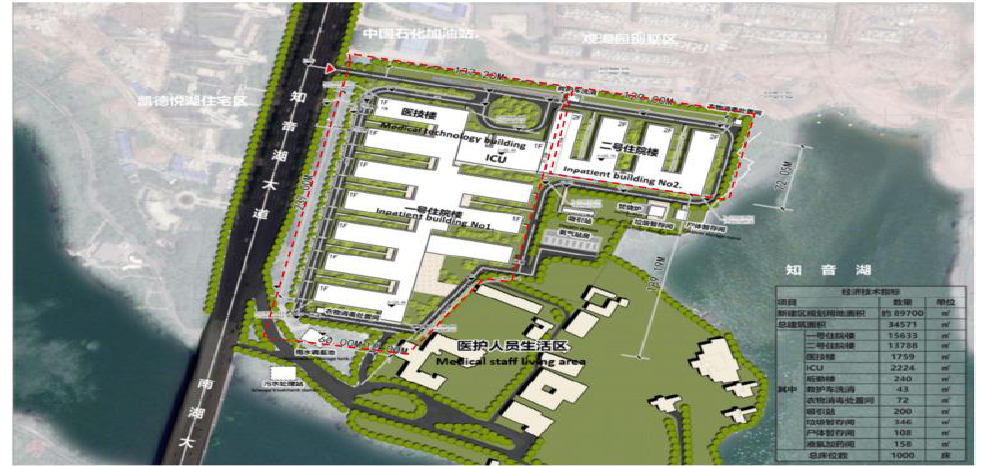
Figure 2. Wuhan Huoshenshan Hospital Building Layout [84].